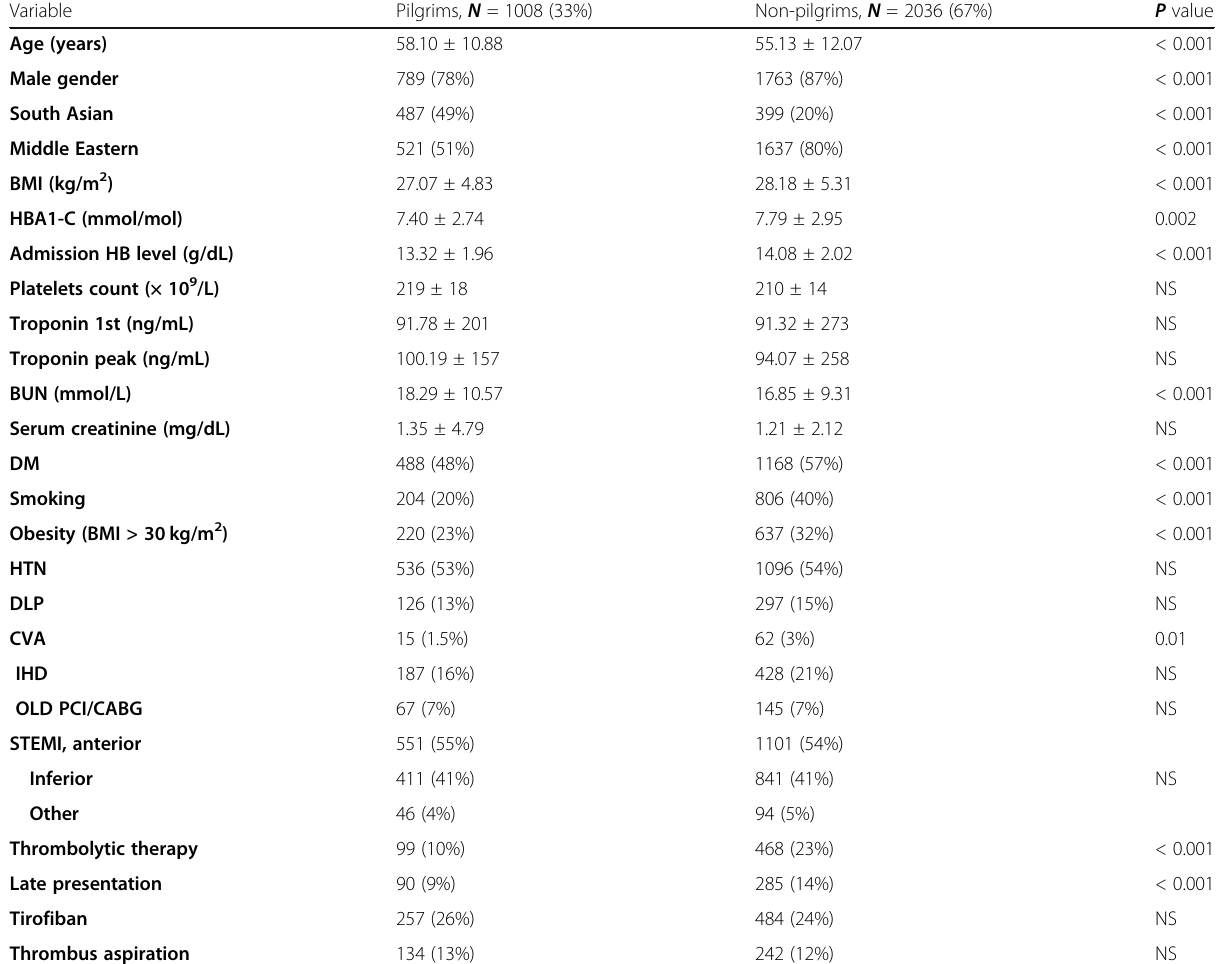
Table 1 Baseline demographic data of pilgrim and non-pilgrim AMI patients